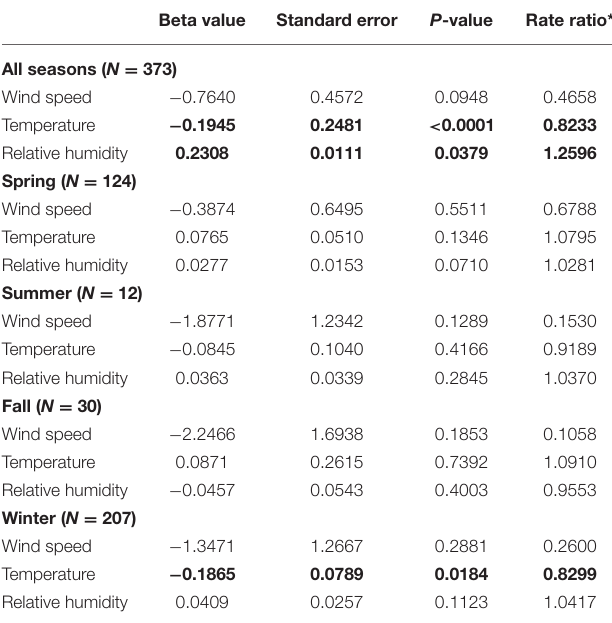
TABLE 4 | Subgroup analyses of the changes of weather parameters on the incidence of unintentional CO